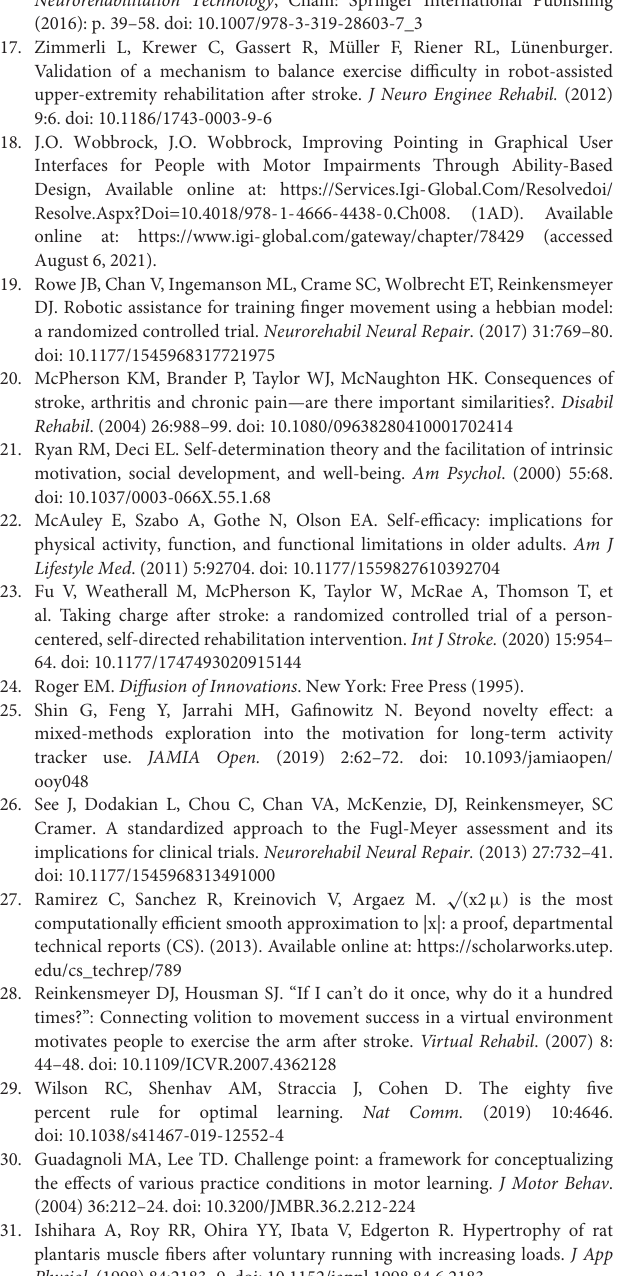
Supplementary Figure S1 | Percent distribution of all exercises done in the (A) Arms, (B) Core, (C) Legs, and (D) Hands regions by users in the study. The exercises for each region are plotted in order of difficulty from left to right. Initially the first three exercises of each region are unlocked. As the user levels up, exercises are unlocked in order of increasing